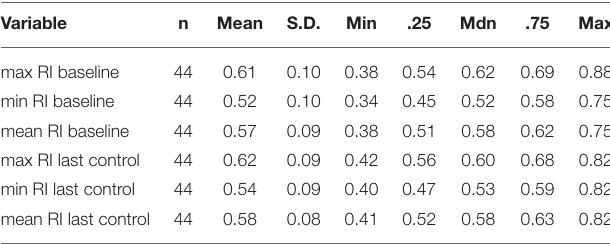
TABLE 3 | RI values at the baseline and at the last post-treatment